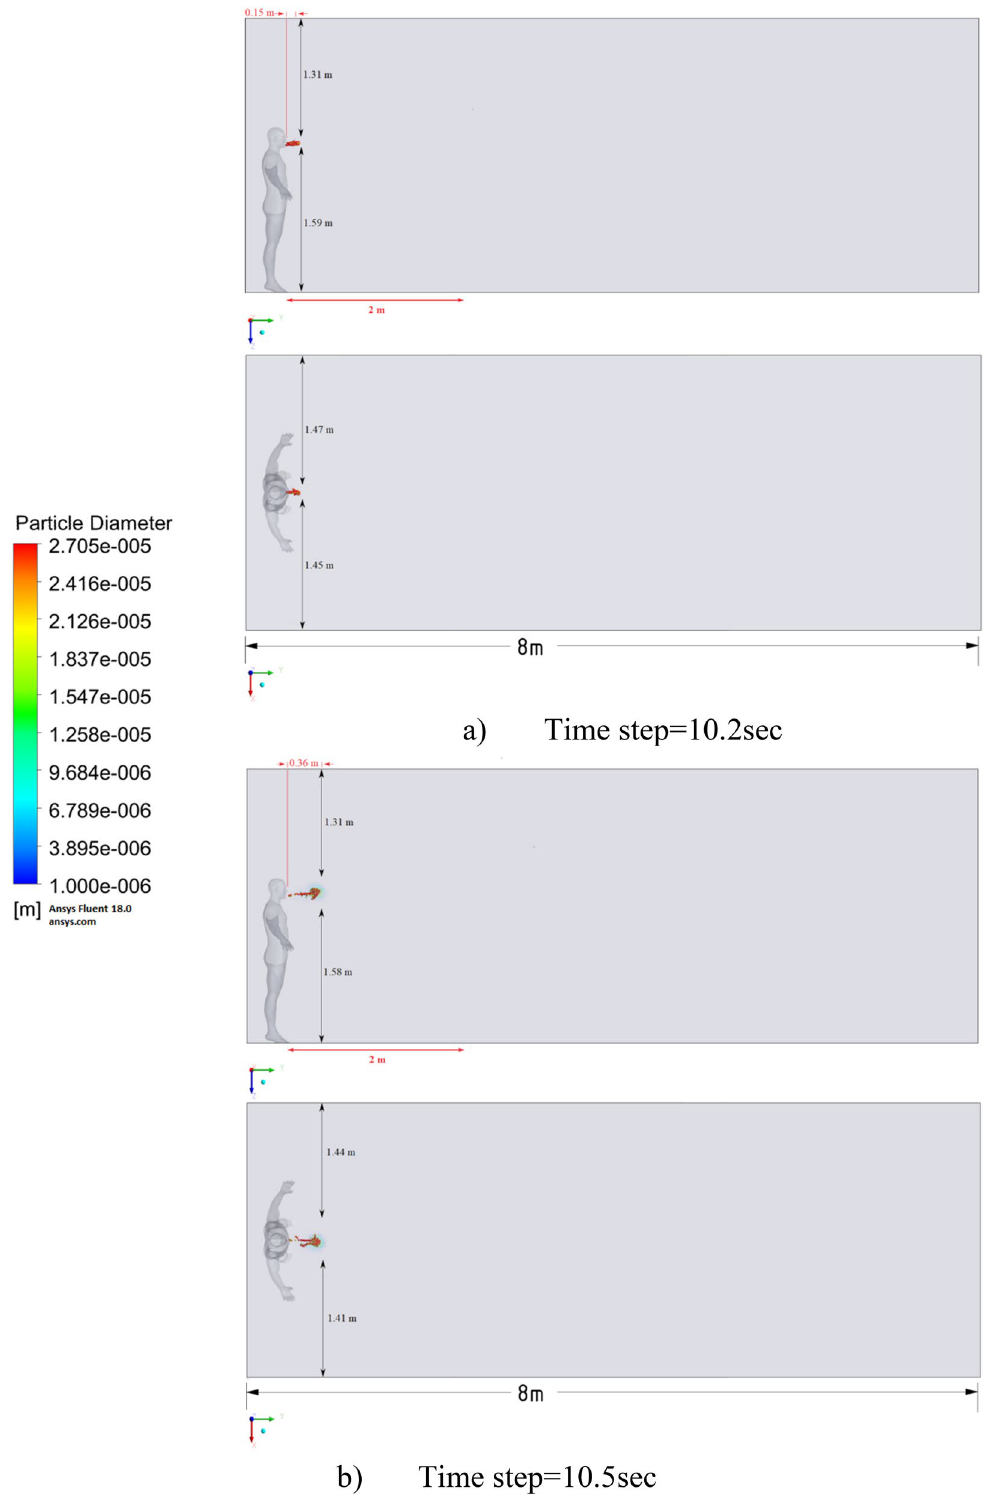
Figure 16. Distribution of the particles for cough = 6 m/s and ventilation = 0.5